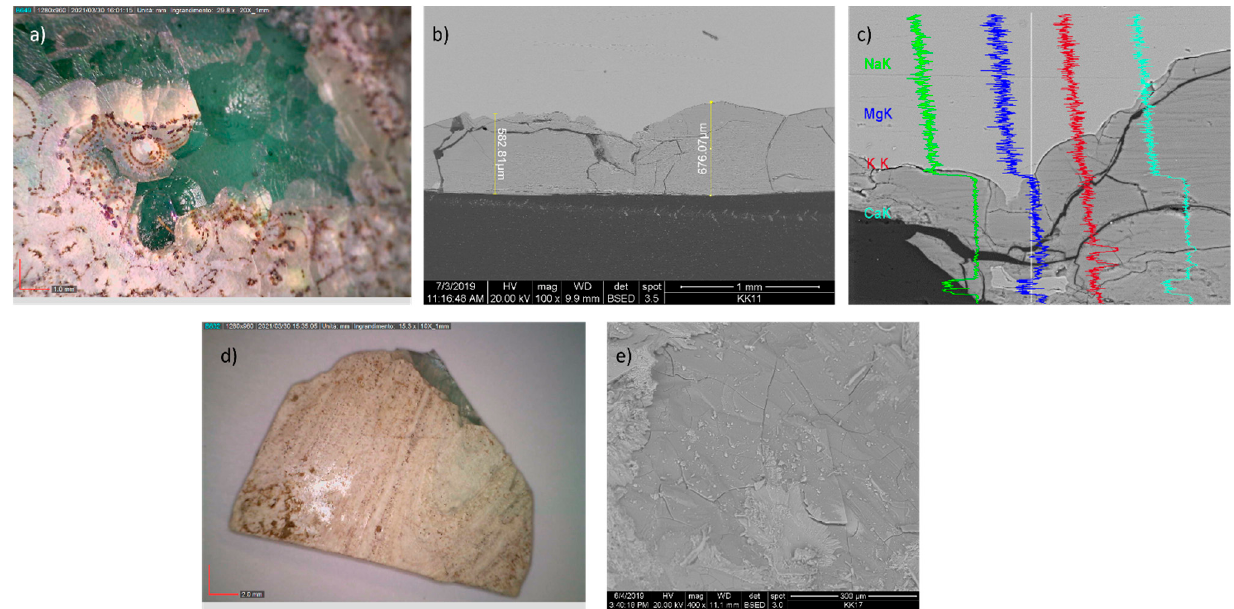
Figure 4. Opaque weathering: ( a ) OM documentation of fragment KK_b2; ( b ) BSE image of KK_b2 cross-section, with detail of the alteration layer penetrating inside the glass; ( c ) EDS line scan through the altered surface and the pristine glass; ( d ) OM documentation of fragment KK_d7, with enamel-like weathering; ( e ) BSE images of fragment KK_d7, untreated sample.